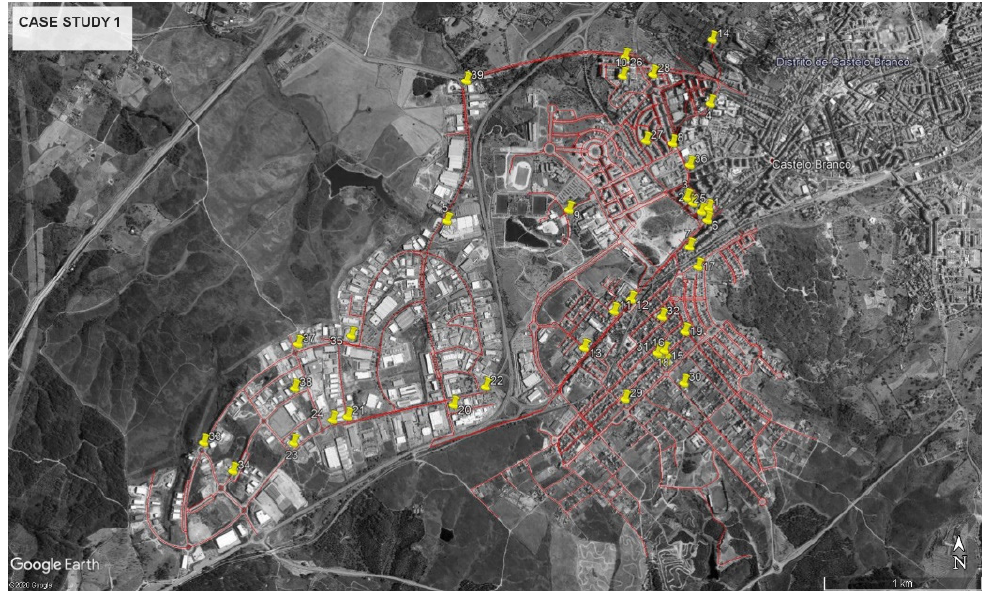
Figure 3. Case Study 1 water distribution system and water quality sampling locations.